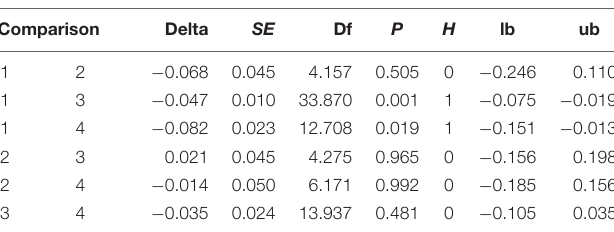
TABLE 4 | Single-step Games-Howell